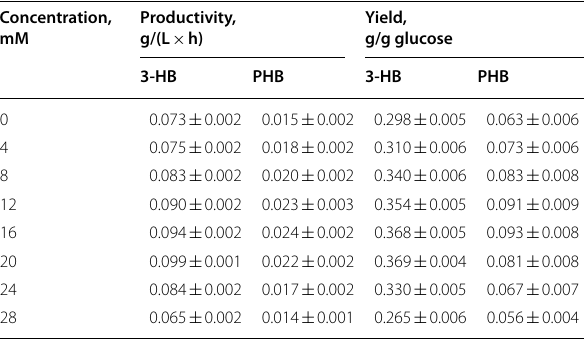
Table 4 The productivity and yield of 3-HB and PHB at different Na HPO 2 4